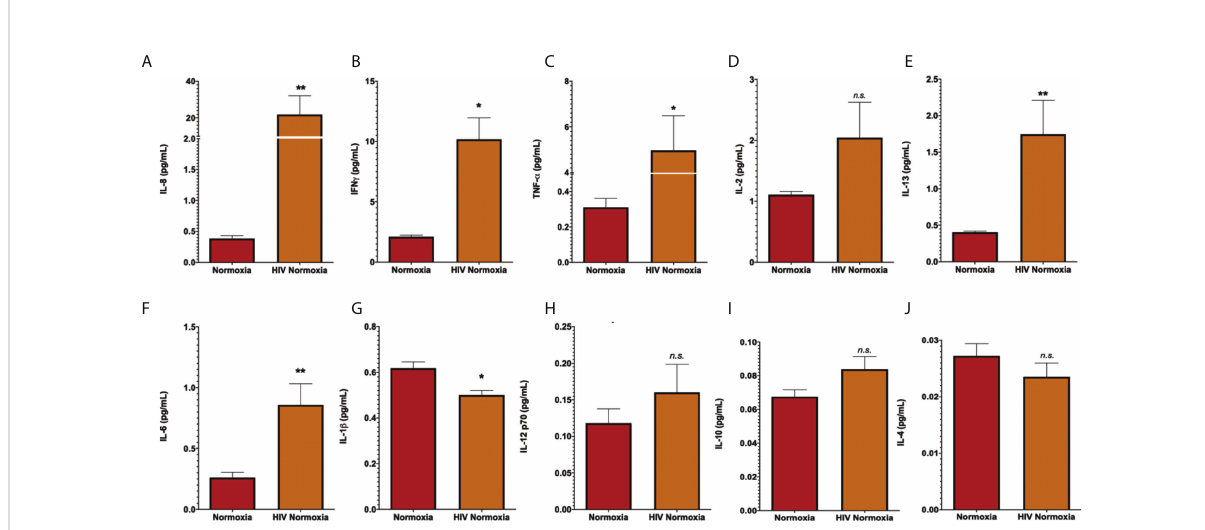
FIGURE 2 Increased of in fl ammatory cytokines in lung lavages of HIV-infected humanized mice. Human pro-in fl ammatory cytokines were measured in lung lavage fl uids of humanized mice by electrochemiluminescence, using the MSD Human Pro-in fl ammatory Panel I 10-plex (Meso Scale Discovery). Panels show detection for IL-8 (A) , IFN-a (B) , TNF-a (C) , IL-2 (D) , IL-13 (E) , IL-6 (F) , IL-1b (G) , IL-12 p70 (H), IL-10 (I) , and IL-4 (J) . Neat lavage fl uids were diluted 1:200, in duplicates. All values with >20% coef fi cient of variability were excluded. Data are shown as mean cytokine concentration (pg/mL), SEM; n= 18 mice (5 males and 13 females). Statistical differences (*p < 0.05, **p < 0.01) are indicated by Mann- Whitney tests. ns, non-signi fi